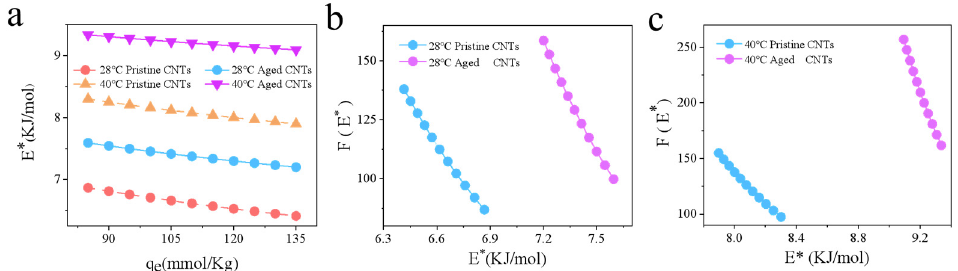
Figure 4. E* of TC adsorption on CNTs ( a ); F (E*) of TC adsorption on CNTs at 28 °C ( b ) and 40 °C ( c ).